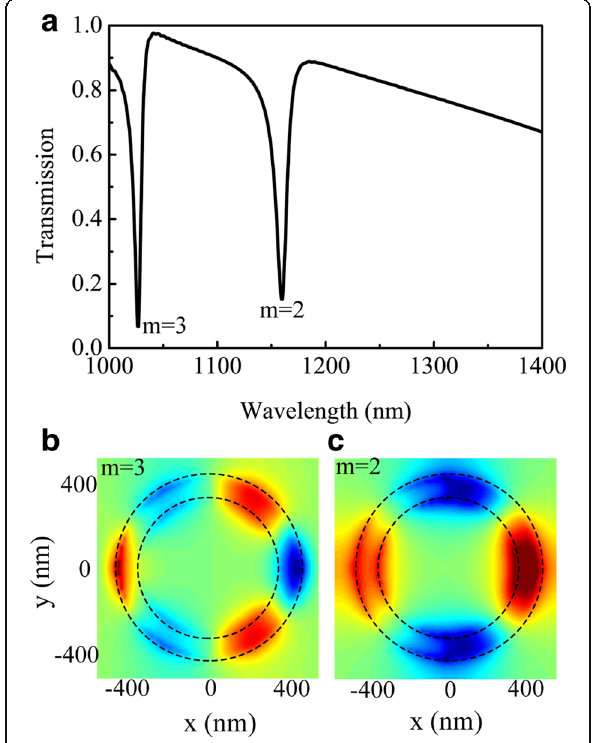
Fig. 3 a Transmission spectra of the coupled system in Fig. 1 (denoted by black line) through the half silver nanoring coupled with the complete silver nanoring. b , c Distributions of z -component of electric field at wavelengths of 1027 ( m = 3) and 1160